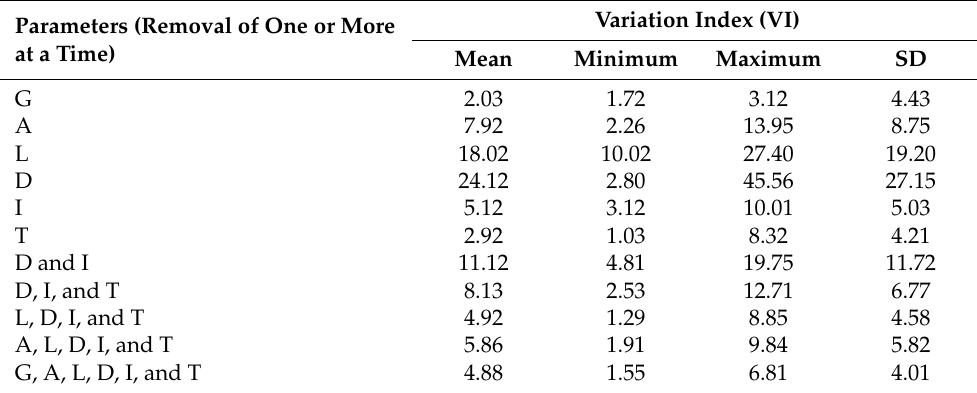
Table 7. Statistics summaries of MRSA of GALDIT